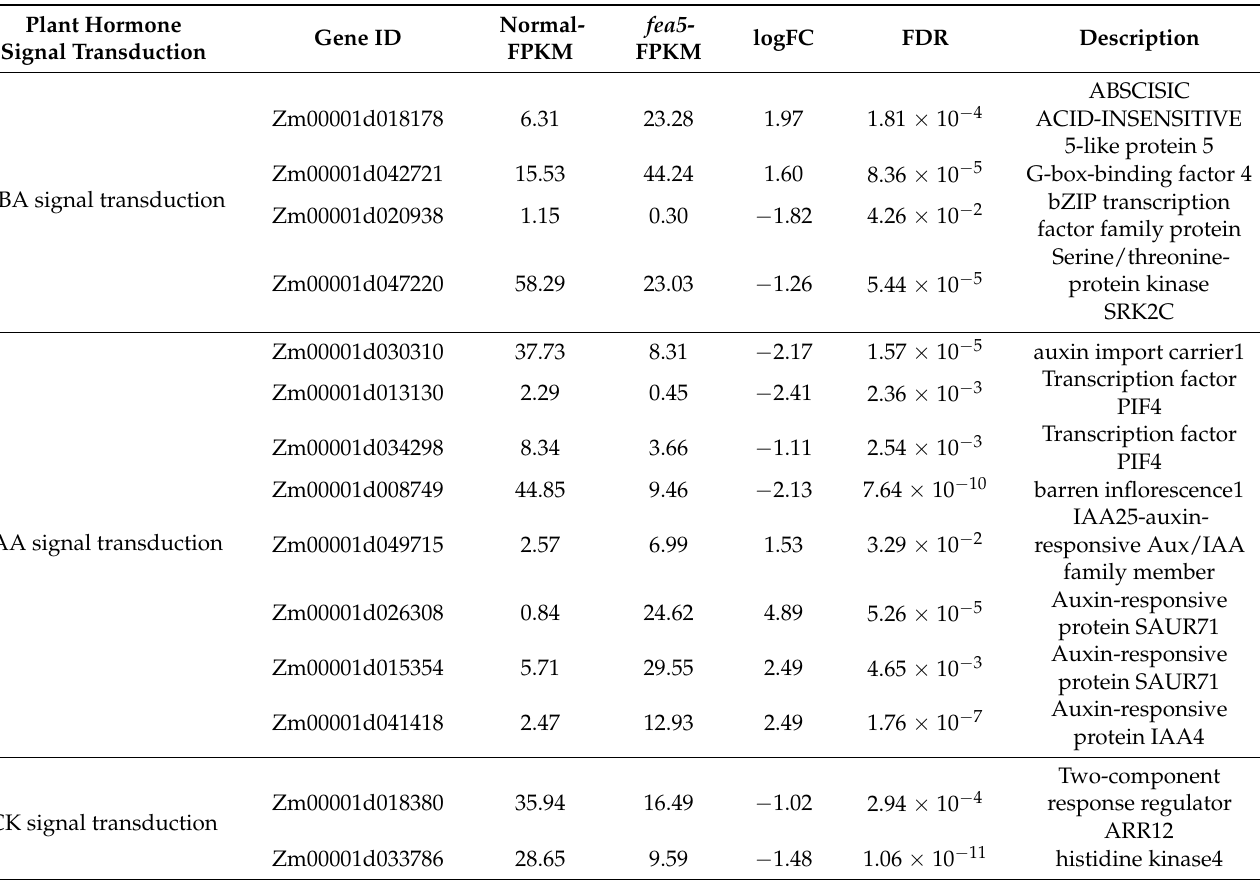
Table 2. Key DEGs identified between normal and fea5 plants involved in phytohormone signal transduction from the transcriptomic